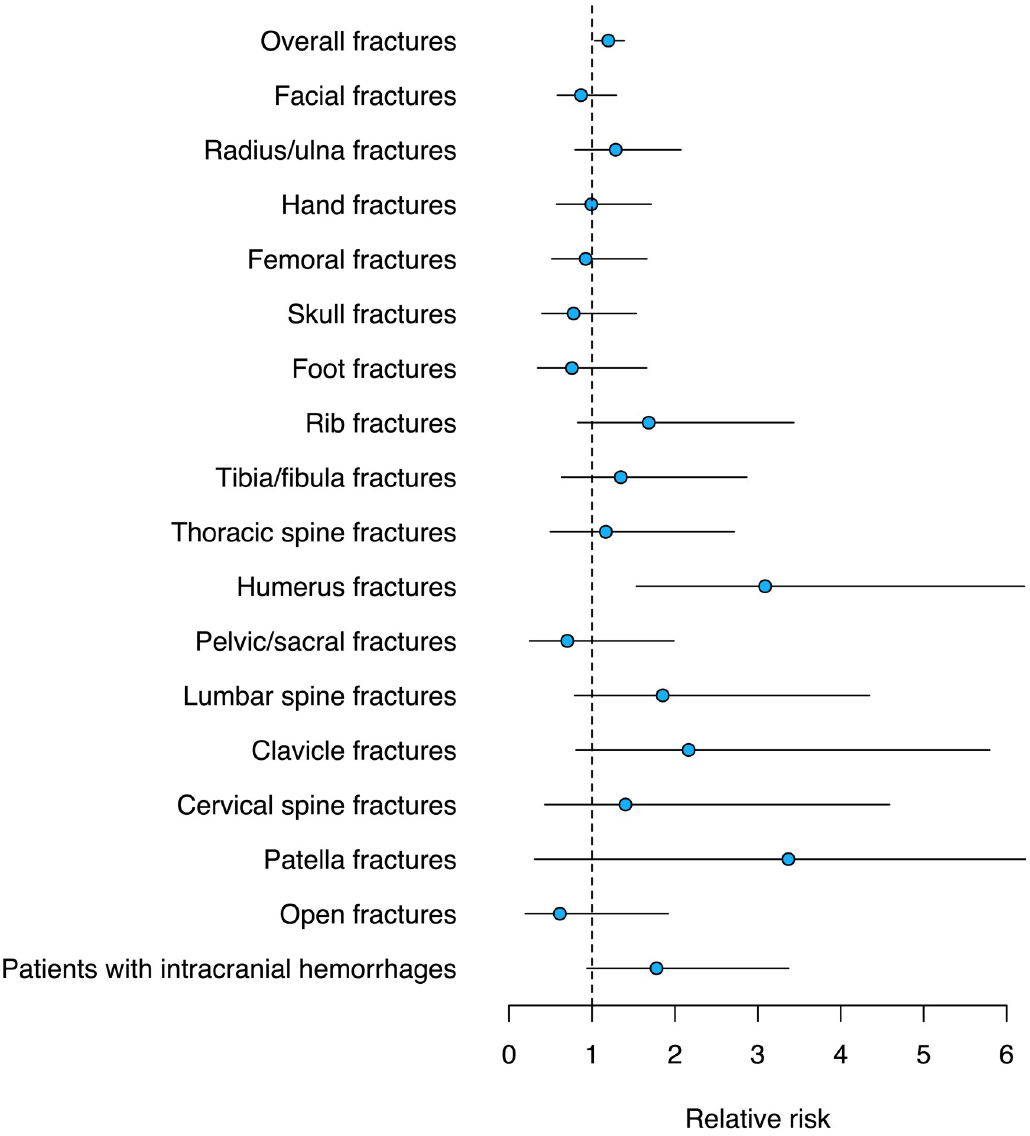
Fig 5. Plot showing RRs during the SHUTDOWN compared to the CTRL period for fractures and patients with intracranial hemorrhages. Circles indicate RRs (SHUTDOWN vs. CTRL) and whiskers the 95% CIs. Numbers are presented in Table 3.